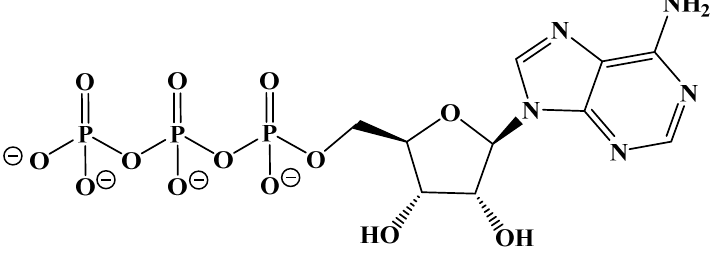
Figure 3. Adenosine Triphosphate (ATP).